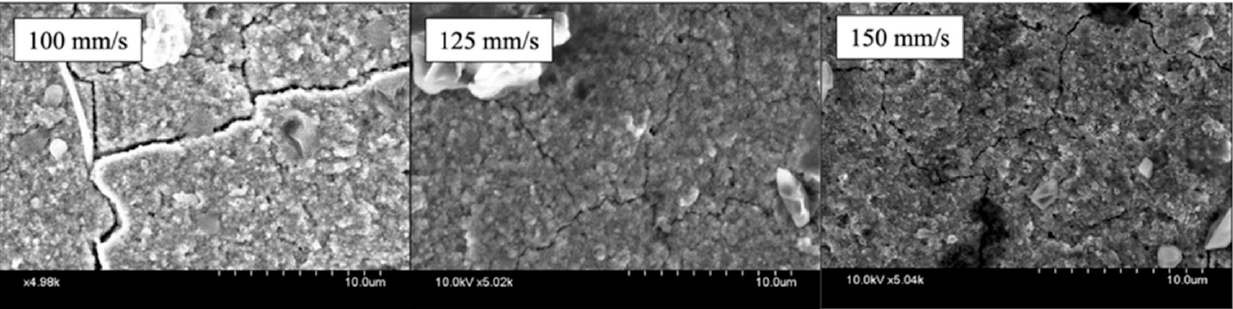
Figure 13. SEM morphologies of 2.5W sintered thin films with varied scanning speeds.